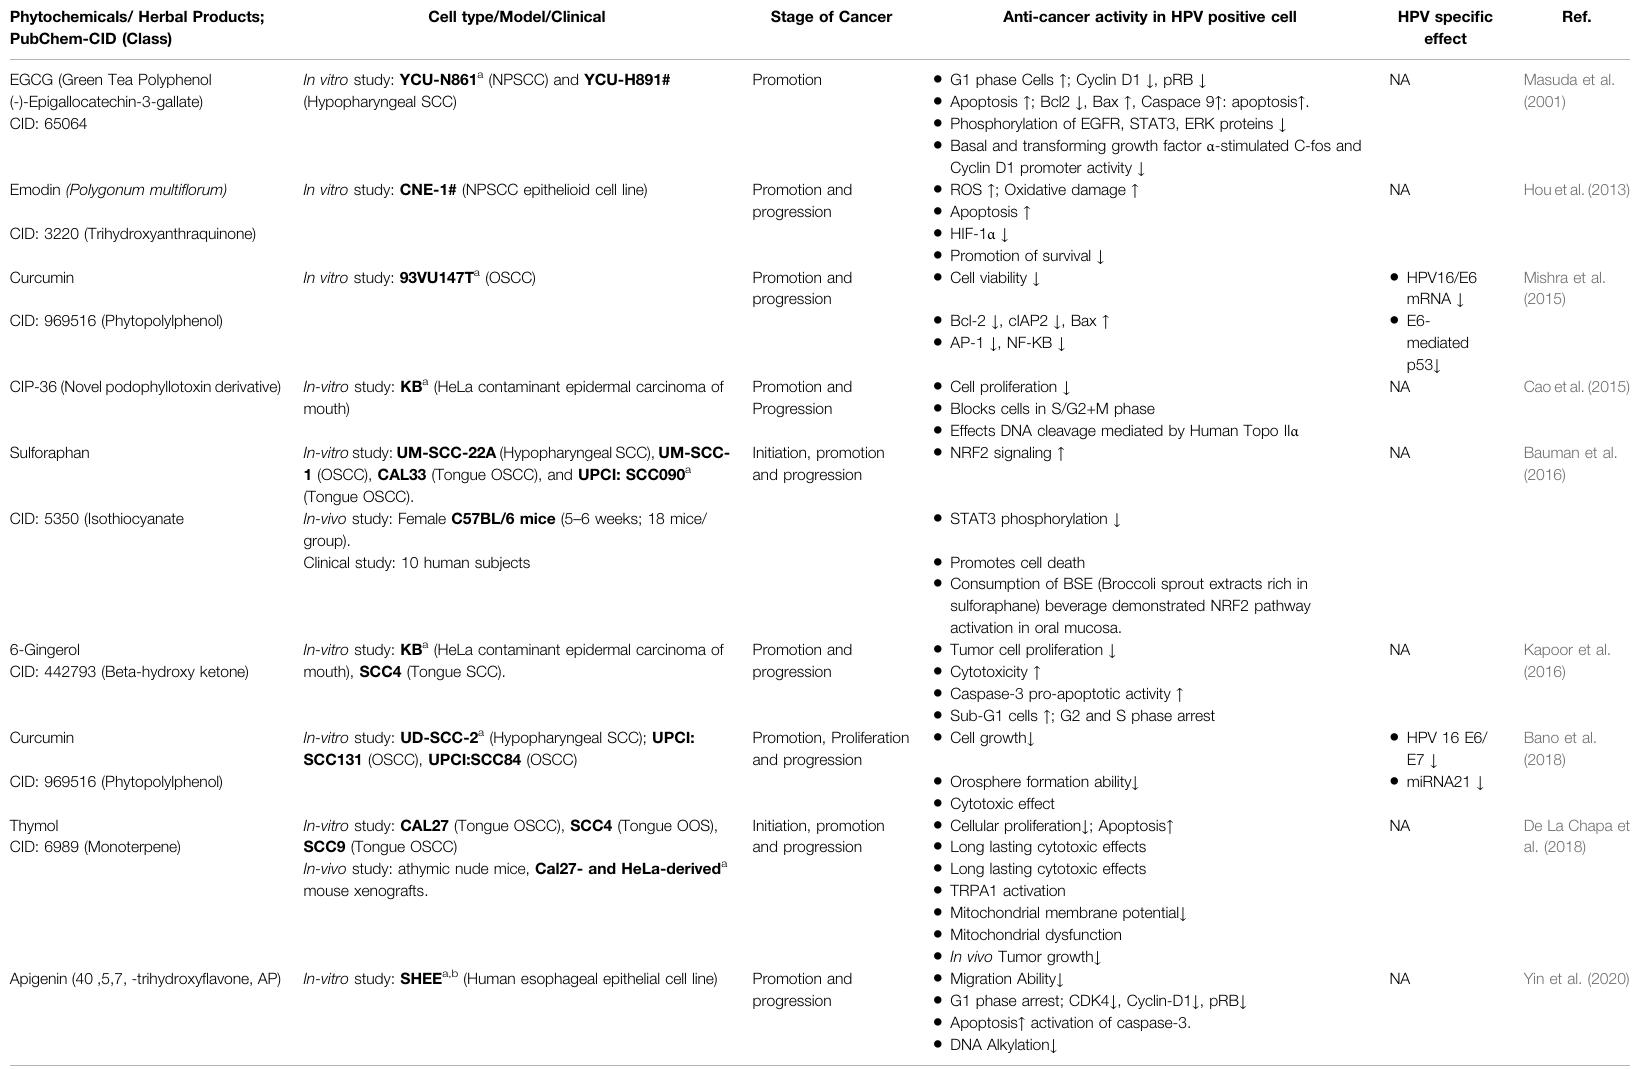
TABLE 9 | Chemotherapeutic and Chemopreventive phytochemicals/Herbal derivative with anti-cancer and anti-HPV activity in HNC. Phytochemicals/ Herbal Products; PubChem-CID